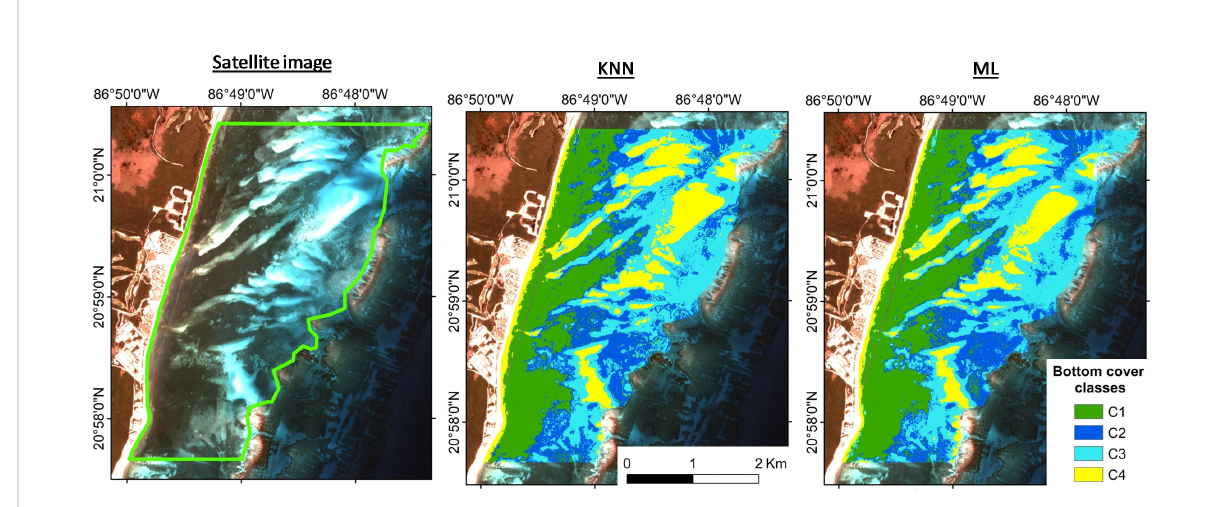
FIGURE 8 Supervised classi fi cation results obtained with multiparameter seeds, using K-nearest neighbors (KNN) and Maximum likelihood (ML)